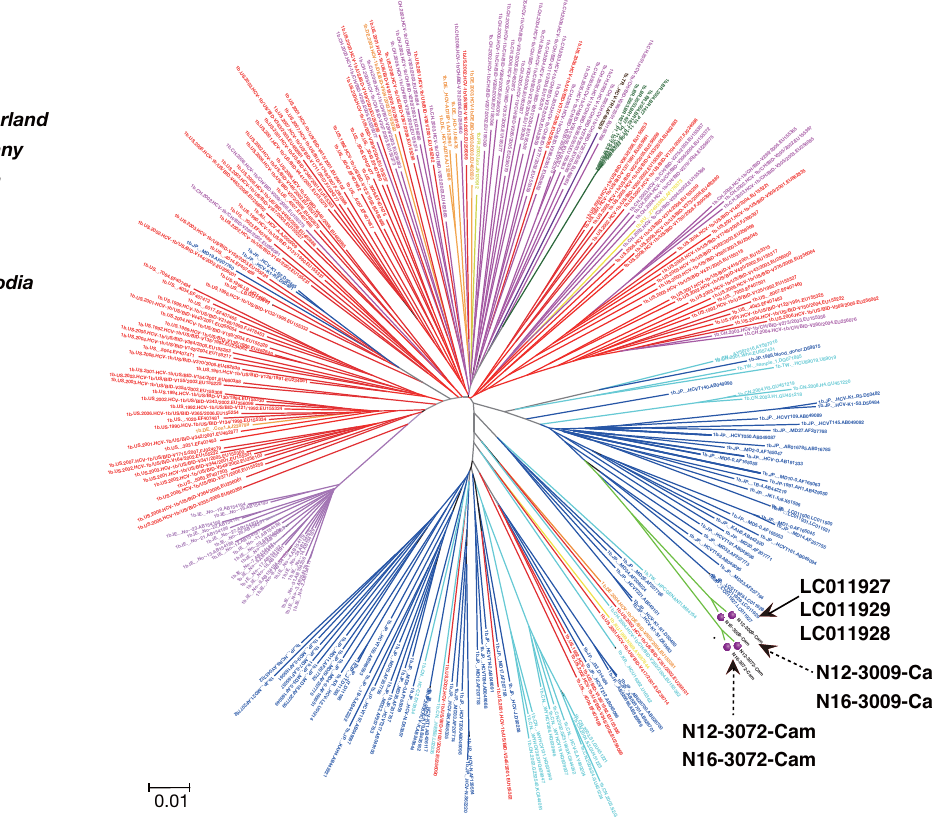
Figure 2. Phylogenetic trees of HCV genotype 1b near full-genome sequence. GenBank accession numbers are shown in parentheses; scale bar indicates nucleotide substitutions per site. The four genomes characterized in this study are indicated with red